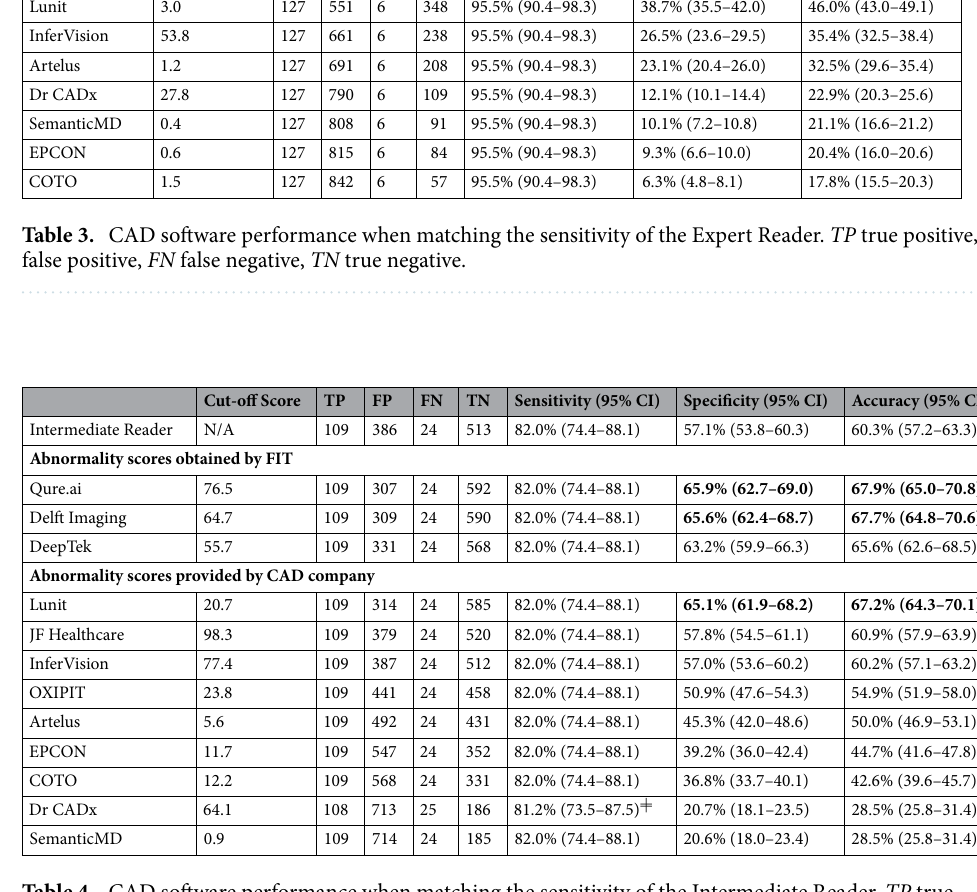
Table 4. CAD software performance when matching the sensitivity of the Intermediate Reader. TP true positive, FP false positive, FN false negative; TN True Negative. Bolded figures indicate performance significantly higher than the Intermediate Reader. ╪ It was impossible to select a cut-off score achieving 109 true positives, as two Xpert-positive participants have the same